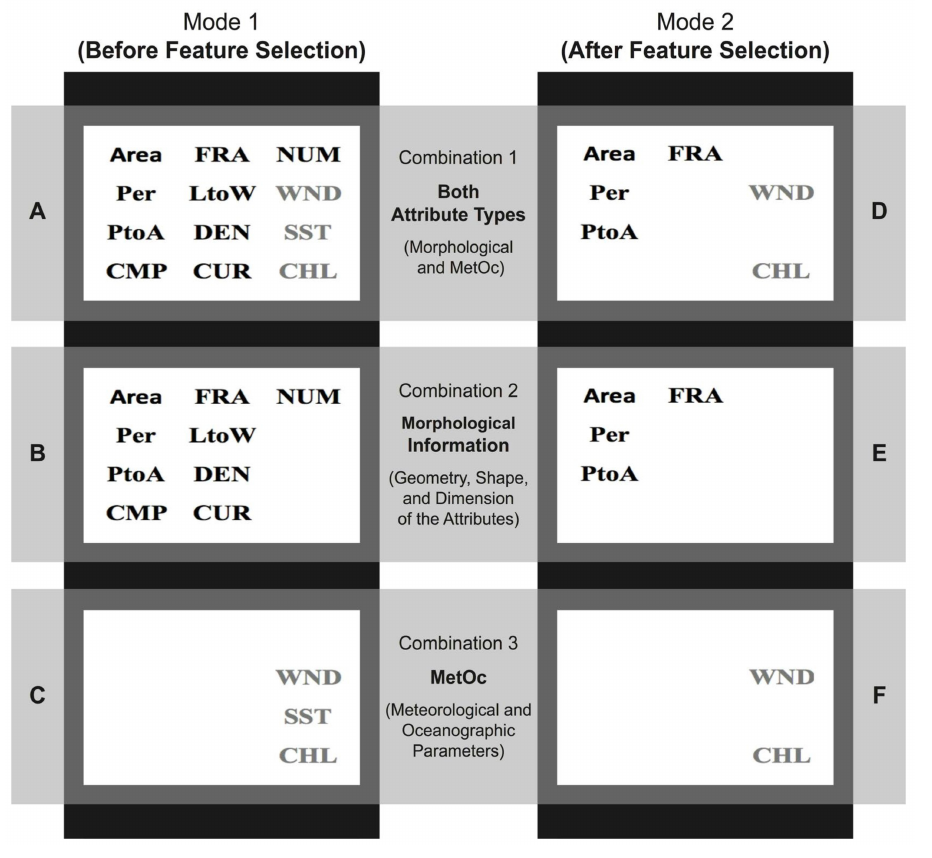
Figure 5. Six variable sets (A, B, C, D, E, and F) that were applied to the machine-learning (ML) classification techniques. Morphological information (black font): Area, Perimeter (Per), Perimeter to Area ratio (PtoA), compact index (CMP), fractal index (FRA), length to width ratio (LtoW), density (DEN), curvature (CUR), and number of target parts (NUM). Meteorological and Oceanographic (MetOc) Parameters (gray font): wind speed (WND), sea-surface temperature (SST), and chlorophyll-a concentration (CHL). See Sections 2.1.4 and